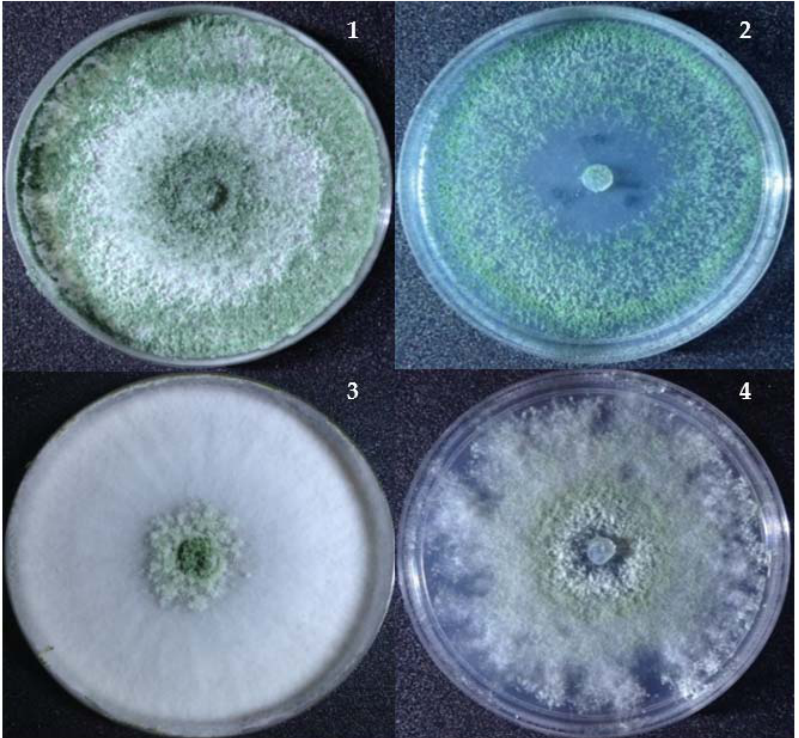
Figure 4. Changes in the colony morphology of Trichoderma at a high concentration of nickel (NiSO 4 ). ( 1 ) and ( 2 ) T. asperellum (S12) grown on TSM without and with 500 ‐ ppm nickel and ( 3 ) and ( 4 ) T. inhamatum (MW25) grown on TSM without and with 900 ‐ ppm nickel.